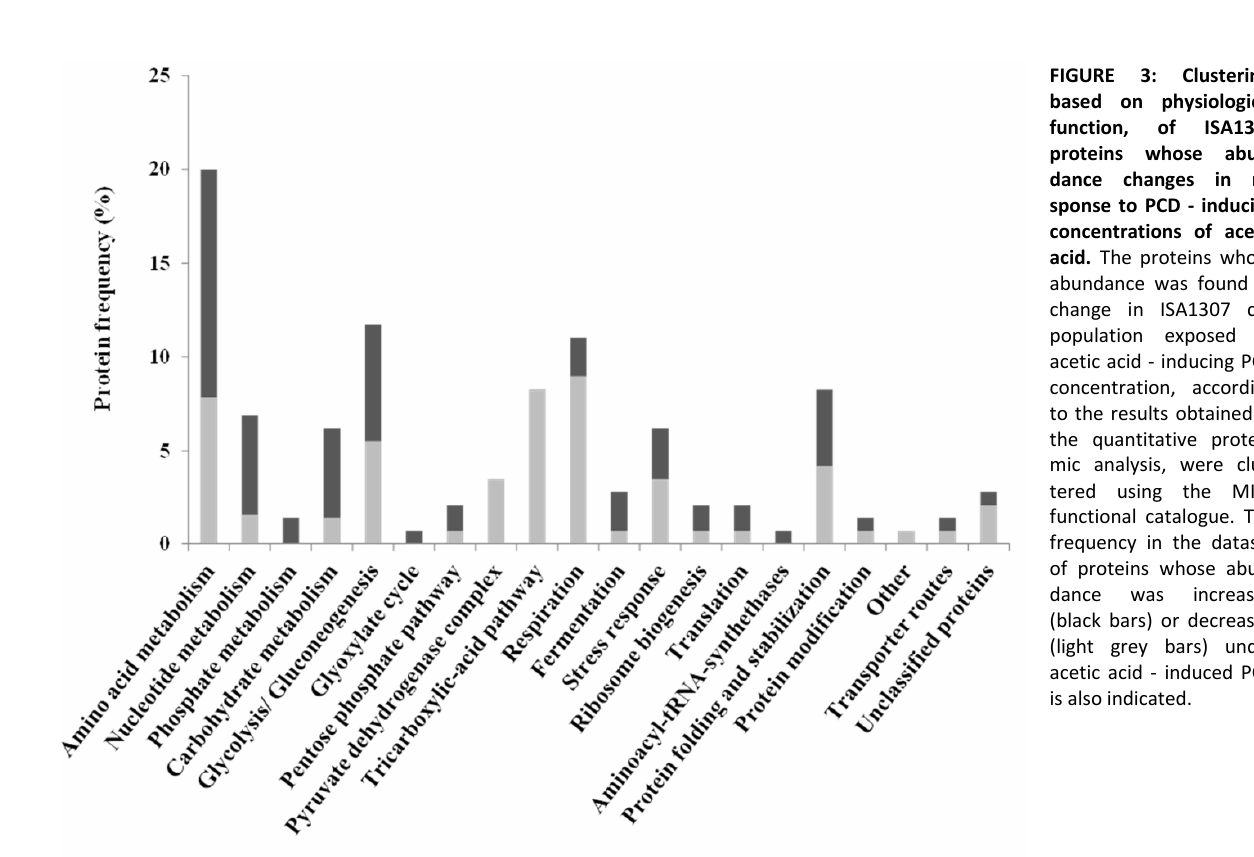
(black bars) or decreased (light grey bars) under acetic acid - induced PCD is also